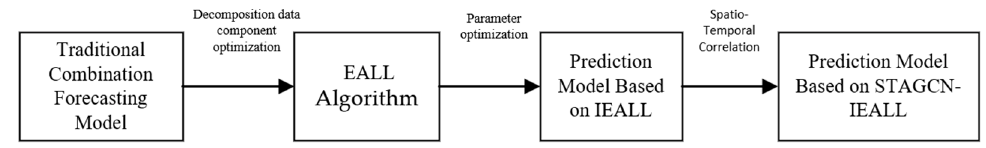
Figure 1. Optimization diagram of composite model.